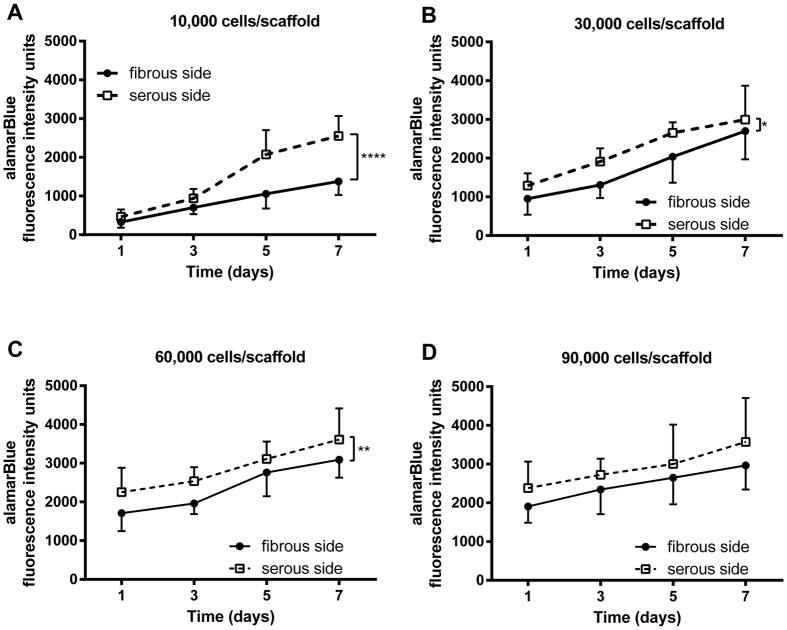
hMSC proliferation on ASB-14 scaffolds at increasing seeding densities.(A) 10,000 cells/scaffold; (B) 30,000 cells/scaffold; (C) 60,000 cells/scaffold; and (D) 90,000 cells/scaffold. After 7 d cultivation, cells significantly expand at all cell densities. Greater cell proliferation occurs following serous seeding than for fibrous seeding for initial seeding densities of between 10,000 and 60,000 cells/scaffold. Data are shown as the mean ± standard deviation (n = 7 per group, *p < 0.05, **p < 0.01, ****p < 0.001).